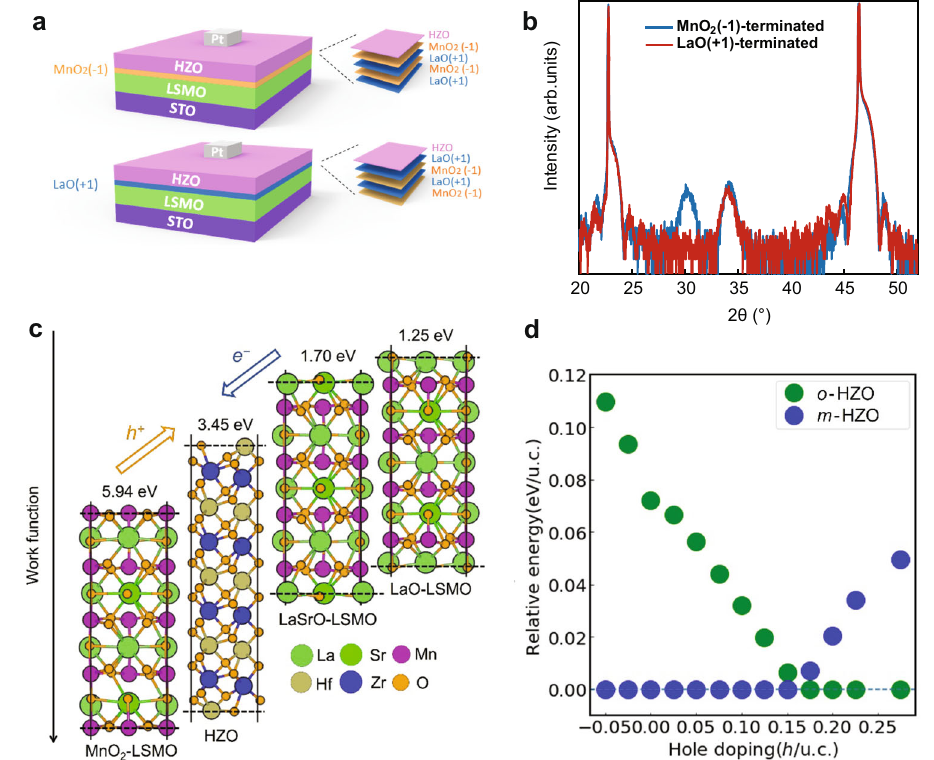
Fig. 4 | Interface charge tuning and theoretical results. a Schematic of the MnO 2 ( − 1) -terminated structure (top) and LaO (+1) -terminated structure (bottom) obtained by inserting a 2-unit-cell LaMnO 3 layer between HZO and LSMO layers. The resulting termination is MnO 2 ( − 1) with a negative ionic charge or LaO (+1) with a positive ionic charge for A- and B-type heterostructures, respectively. b XRD data for the MnO 2 ( − 1) -terminated structure (blue curve) and the LaO (+1) -terminated structure (red curve). c Calculated work functions of o -HZO, MnO 2 -terminated